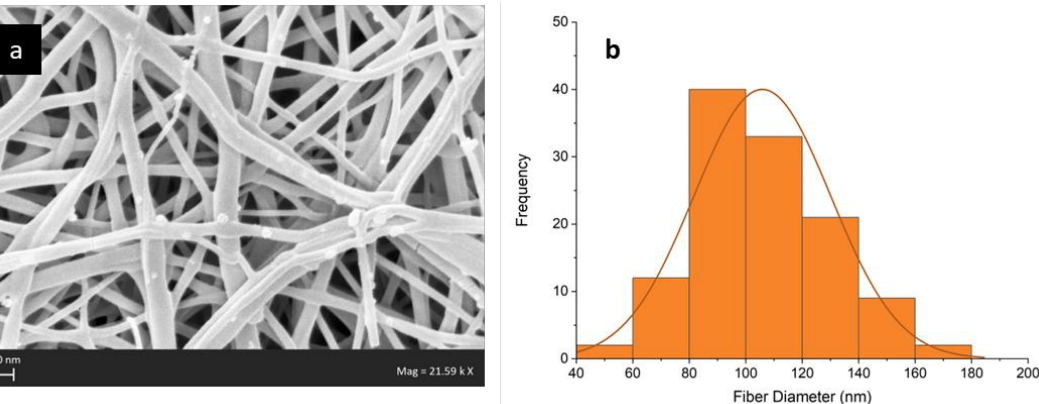
Figure 5. ( a ) SEM Image and ( b ) size distribution of electrospun nanofiber mat of QPVA (without matrix).